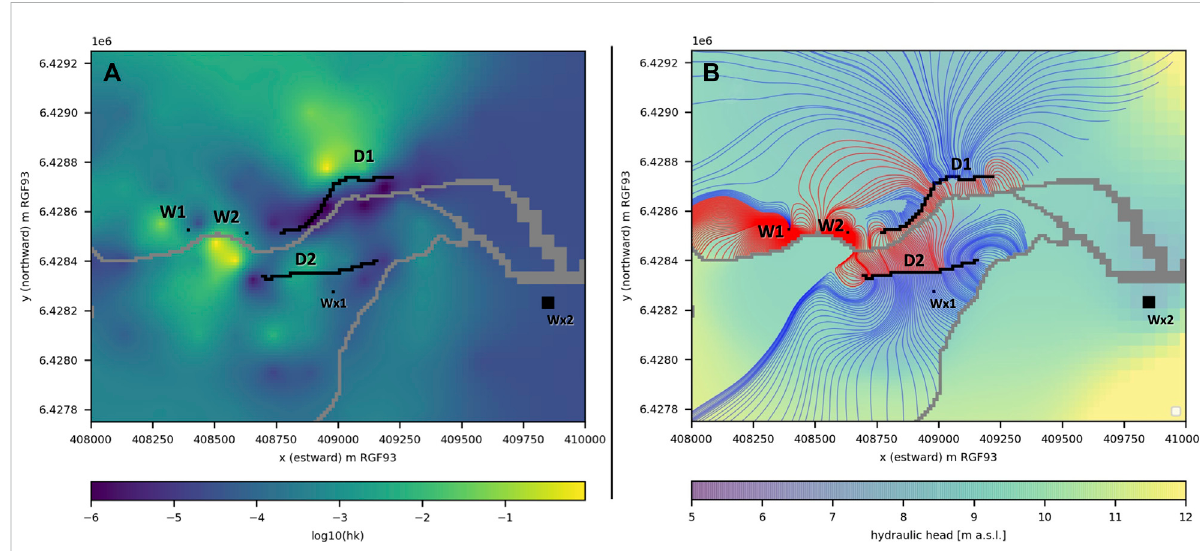
FIGURE 9 (A) Hydraulic conductivity fi eld after parameter estimation. (B) Simulated groundwater table level and particle tracking trajectory for the initial values of parameters Q and α . Particle trajectory from the contaminated stream are colored in red and those from uncontaminated boundaries in blue. Particle tracking was conducted from production wells W1, W2 and drains D1, D2 shown in black. Pumping from wells Wx1 and Wx2 was considered in the fl ow model but they do not pertain to the studied drinking water facility.